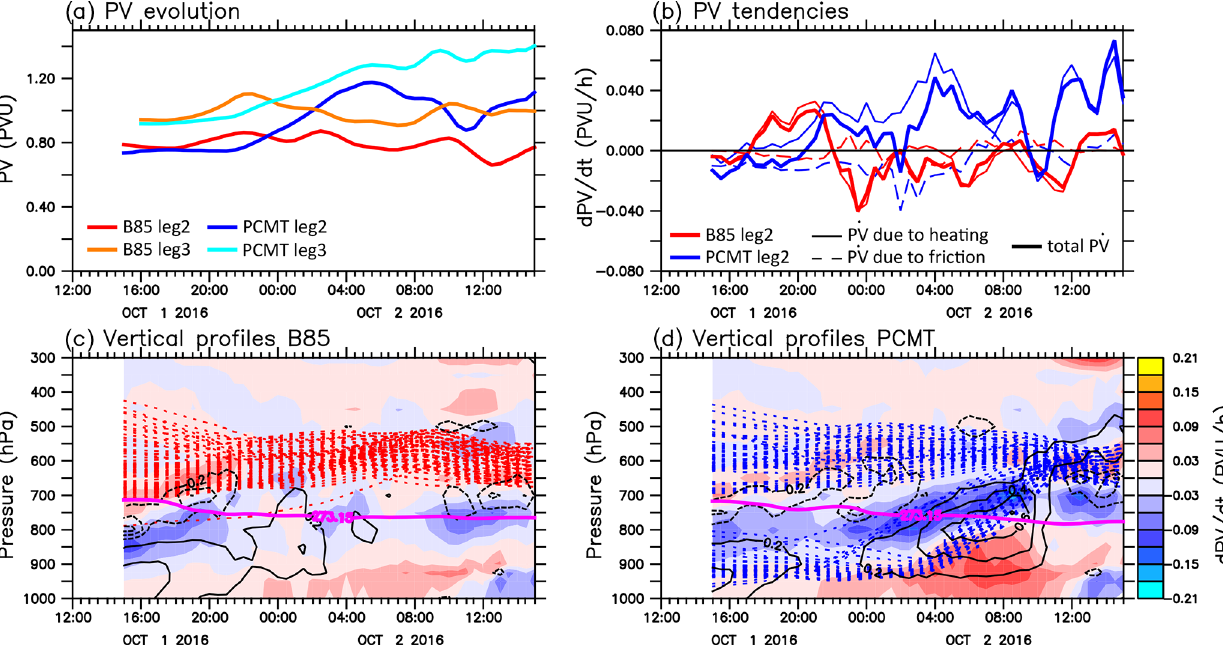
Figure 6. (a) Time evolution of PV for trajectories reaching the positive PV difference in leg 2 (red line for B85 and blue line for PCMT) and leg 3 (orange line for B85 and cyan line for PCMT). (b) Time evolution of PV tendencies due to heating (thin solid lines), friction (thin dashed lines) and total (bold solid lines) for B85 (red) and PCMT (blue). Vertical profiles, according to time, of heating (dashed and solid contours for negative and positive values, respectively; second method of computation) and PV tendency due to heating (shading) along trajectories reaching the positive PV difference for (c) B85 (dashed red curves) and (d) PCMT (dashed blue curves), respectively. The iso-0 ◦ C is the purple